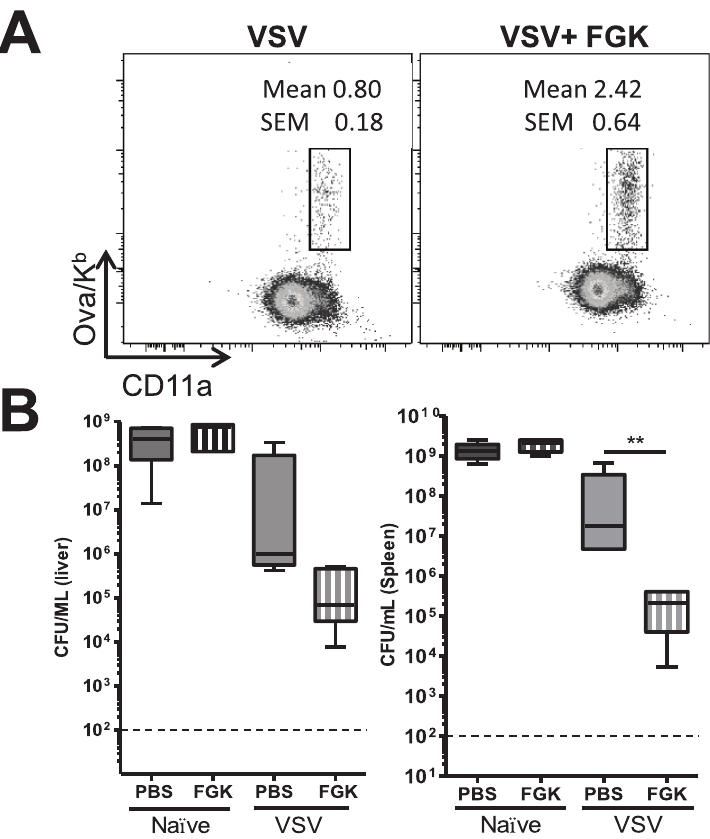
Figure 3. FGK4.5 treatment enhances CD8 + T cell responses induced by VSV infection. C57BL/6 mice were i.v. infected with 2 6 10 5 pfu VSV-ova and treated i.p. with 100 m g FGK4.5, an agonistic CD40 mAb, one day post infection. (A) Sixty days after primary infection the Ova/K b -specific CD8 + memory T cell population in the blood was quantified by Ova/K b -tetramer staining. (B) To assess whether activating CD40 would induce protective immunity, vaccinated mice were re-challenged with 5 6 10 5 cfu LM-ova sixty day after VSV-ova vaccination. Three days later spleens and liver were assessed for bacterial burden. Statistical significance was determined using a one-way ANOVA with a Bonferroni’s post-test (**p , 0.01). Data are representative of at least three independent experiments.